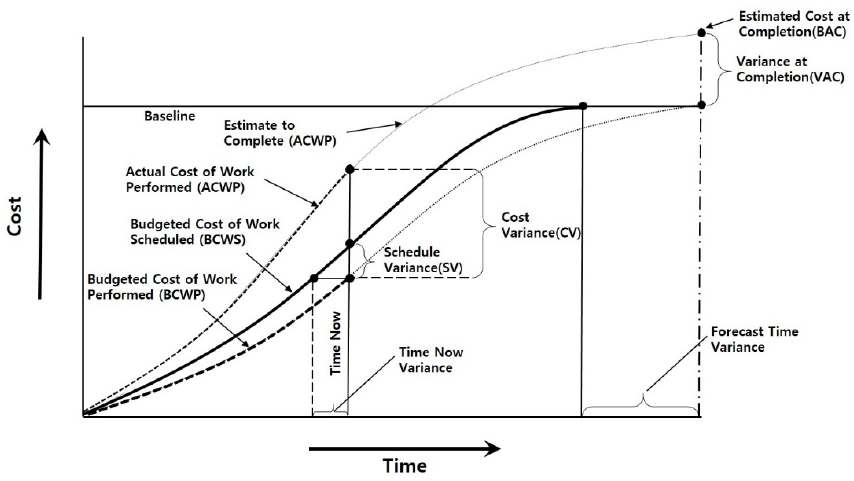
Figure 3. Earned Value Management System (EVMS) diagram through the S-Curve.